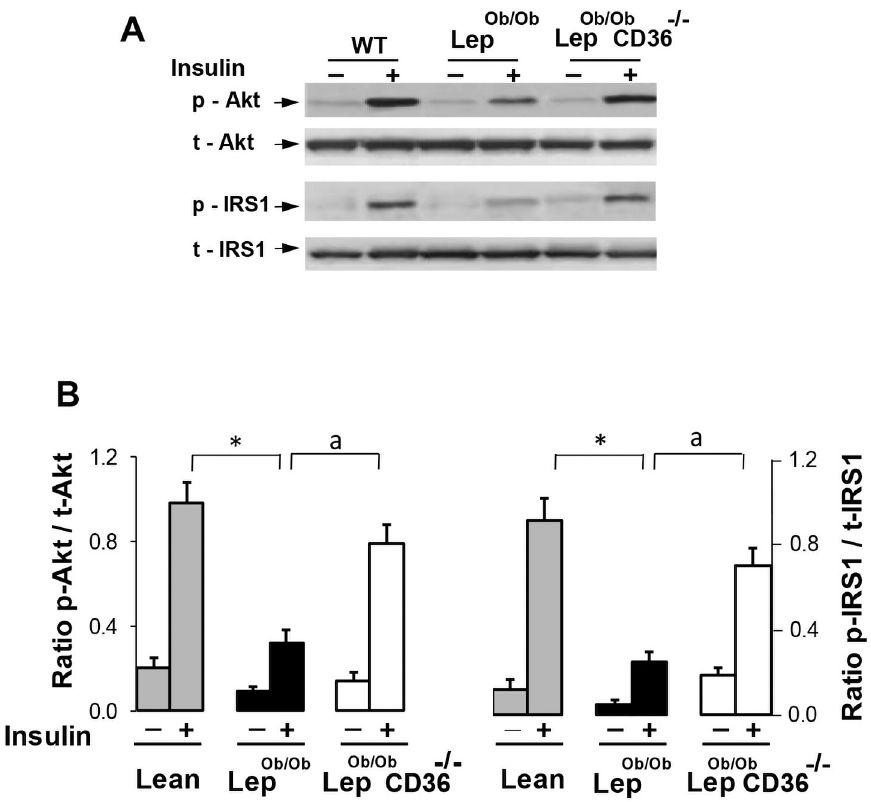
Fig 2. Effects of CD36 deficiency on insulin signaling. A) Representative blots and B) ratio of phosphorylated (p) to total (t) Akt and IRS1 in hearts 10 minutes after insulin injection. Results are presented as mean ± SEM (n = 5 per group). Statistical differences between Lep ob/ob and Lean mice are indicated with an asterisk * p < 0.01, and differences between Lep ob/ob CD36 -/- and Lep ob/ob mice are indicated with an alphabetic letter with a p <